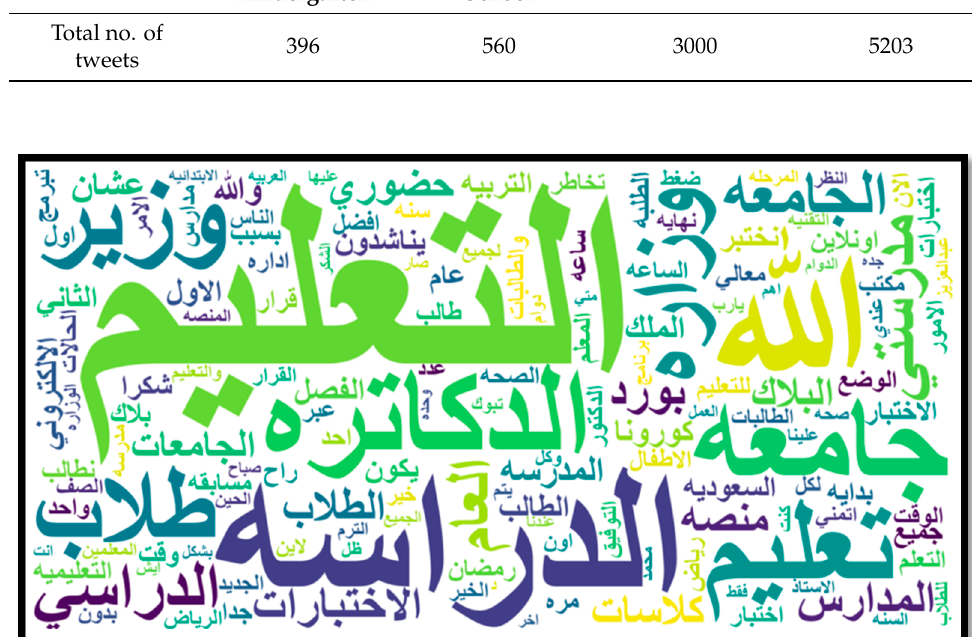
Figure 5. Word Cloud of common words in the application dataset. Table 7. Number of tweets in each educational stage for the second dataset (application dataset).